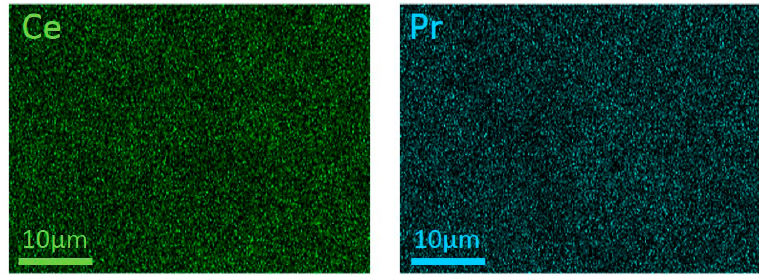
Figure 3. EDX maps of the Ce50Pr50 catalyst showing the distribution of Ce and Pr ions.